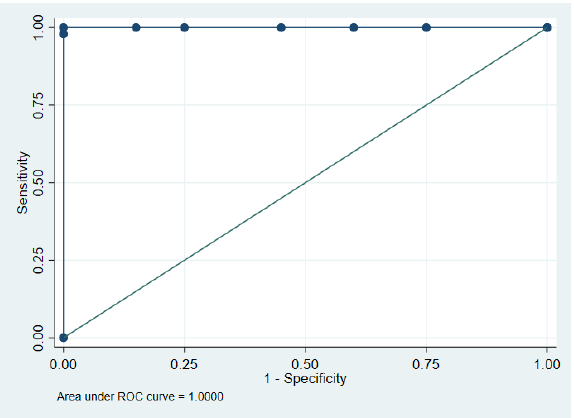
Figure 2. Methylated Homeobox A9 (meth-HOXA9) in lung tissue. Receiver operating characteristic (ROC) curve of meth-HOXA9 in malignant ( n = 48) and non-malignant ( n = 20) lung tissues.